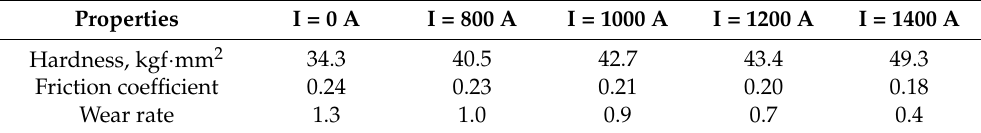
Table 2. Characteristics of the Cu-37.4 wt.% Pb after pulse treatment [37].